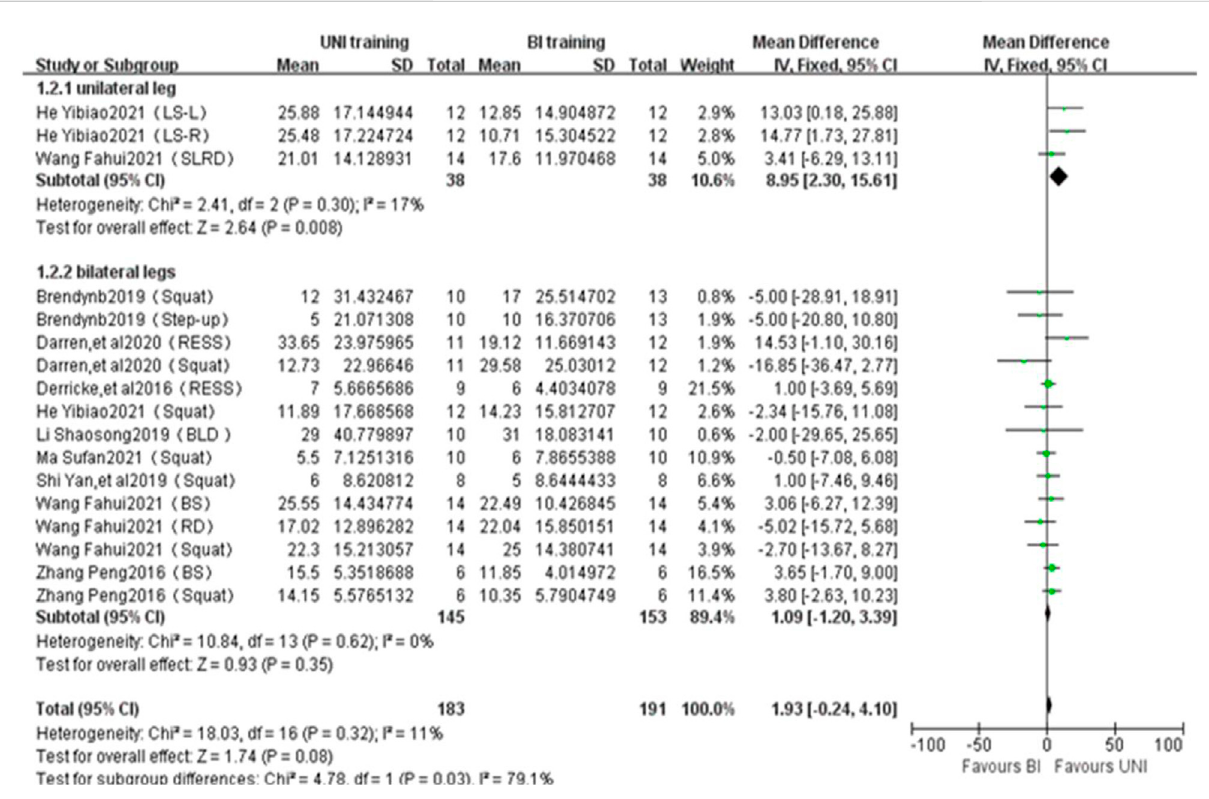
FIGURE 2 IntergroupForestplotsofUNIandBItrainingaffectingMaximalForce.RESS=rearelevatedsplitsquat;LS-L=lungesquatwithleftleg;LS-R=lunge squat with right leg; BLD = bended-leg deadlift; BS = Bulgarian Squat; RD = Romanion deadlift; SLRD = Single-Leg Romanion